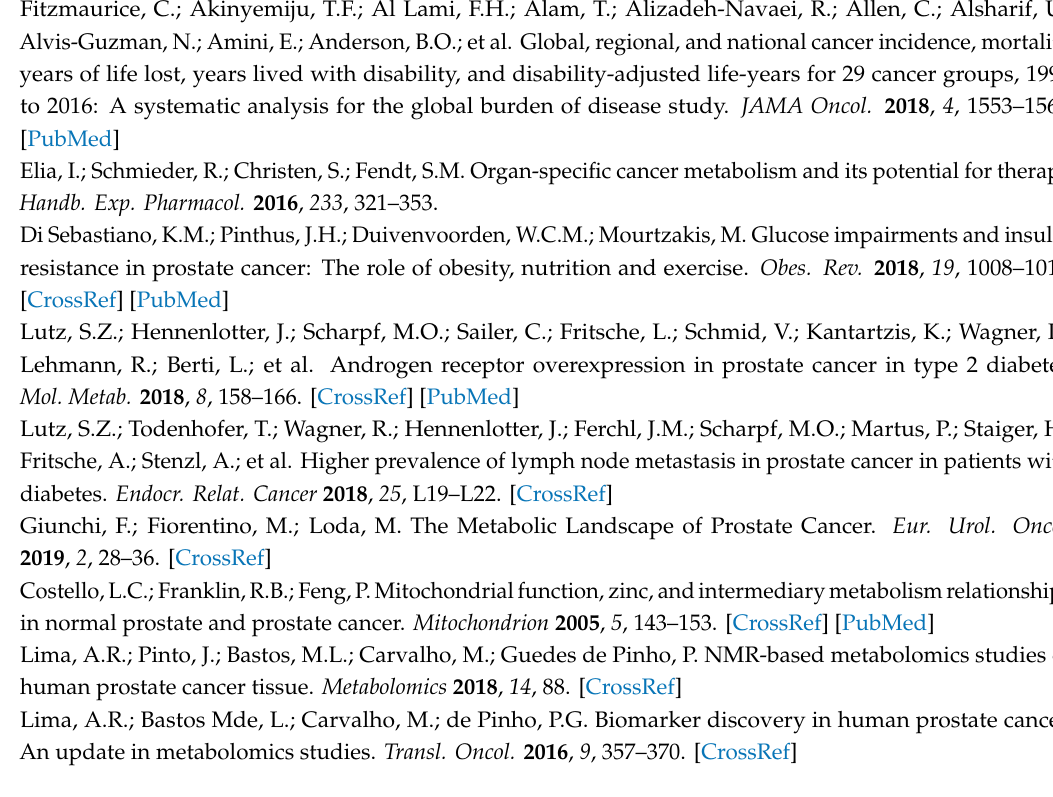
Table S1: CE–MS anion mode metabolites. Table S2: CE–MS cation mode metabolites. Table S3: LC–MS negative mode metabolites. Table S4: LC–MS positive mode metabolites. Table S5: Selected significant metabolites of the mass spectrometry cohort. Table S6: Correlation analysis of the indicated genes from the human cancer genome